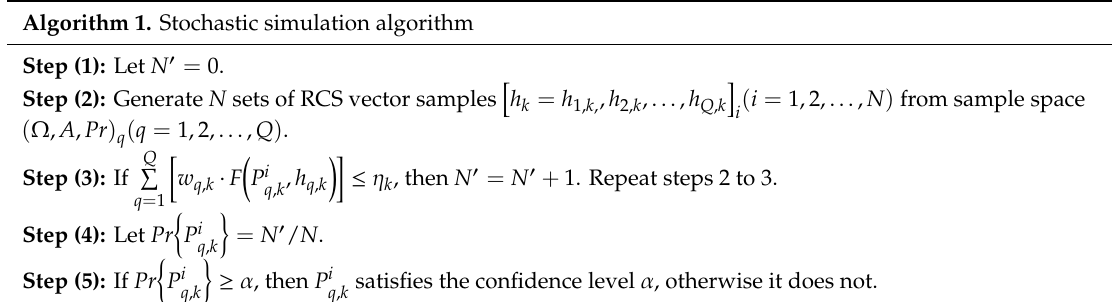
Algorithm 1. Stochastic simulation algorithm